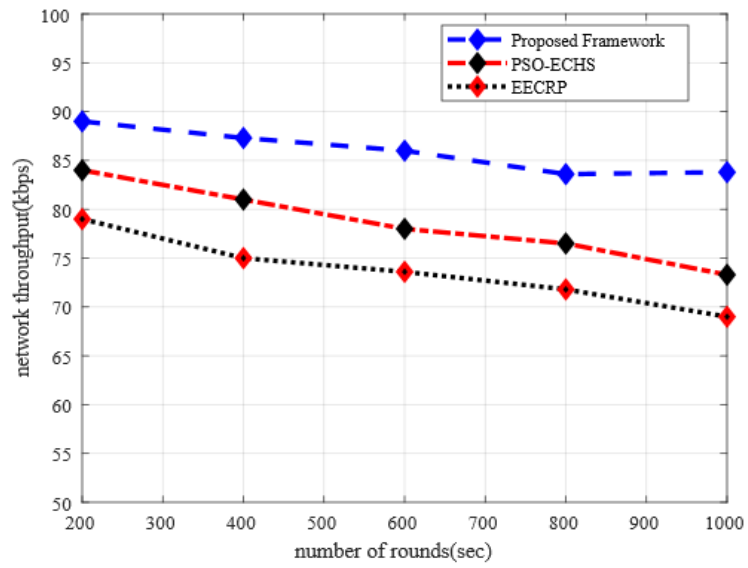
Figure 3. The impact of the simulation rounds on network throughput.